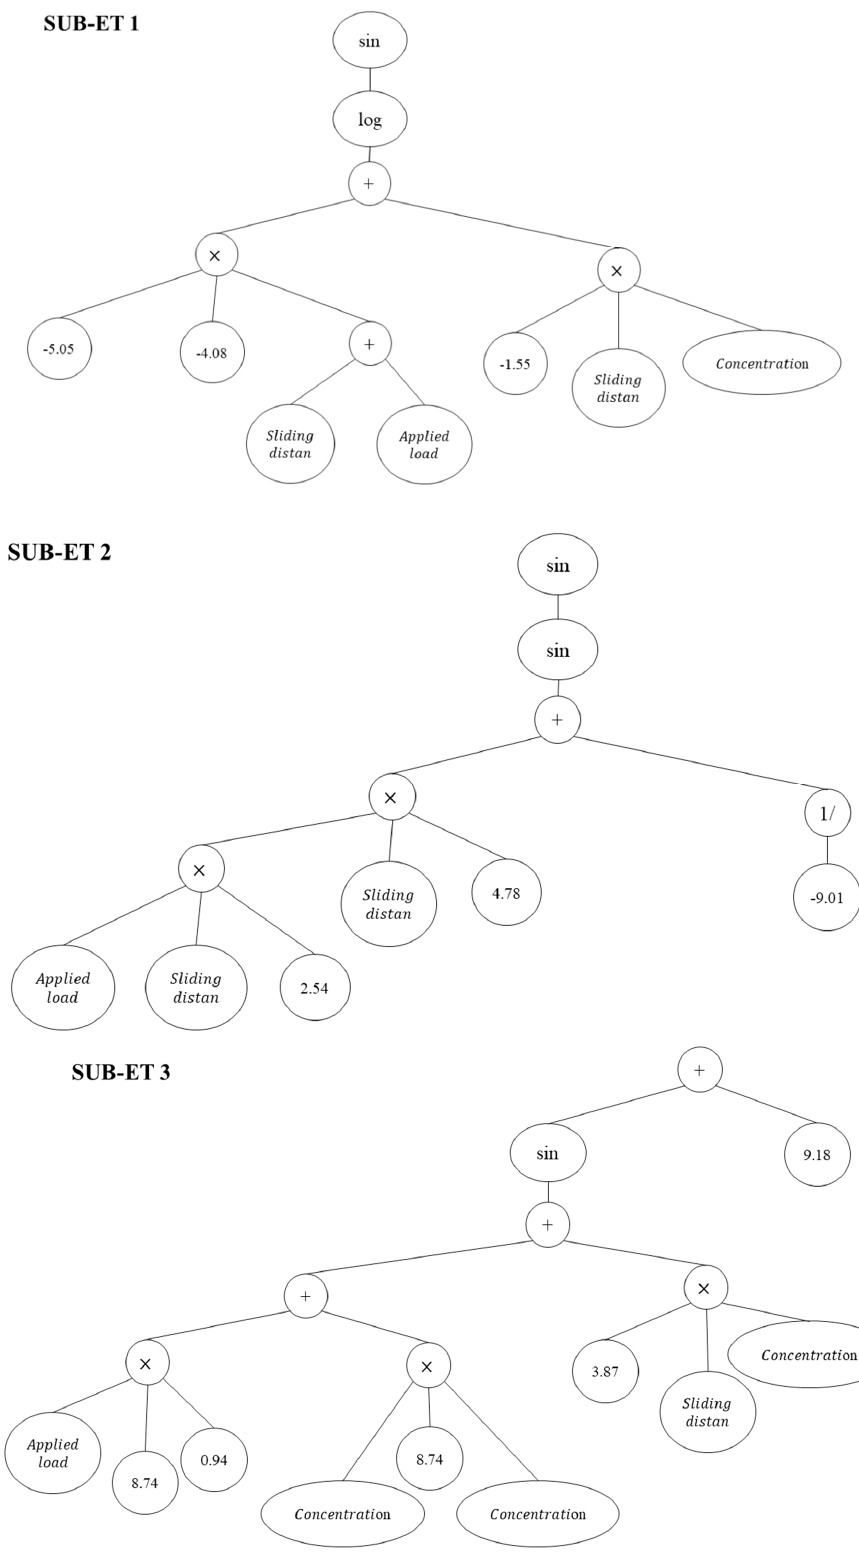
Figure 4. Expression tree (ET) of the GEP-3 (w4) model. By considering the SiC–ZrO 2 –Al hybrid composites, concentration of zirconia, sliding speed, sliding distance, and applied load as practical parameters of wear loss, a sensitivity analysis was employed for the determination of the most effective practical parameter on the microhardness of the nanocomposite coatings. Given that the best model for predict- ing microhardness is GEP-3 (w4), GEP-3 was employed for the sensitivity analysis (w4). In the GEP-3 (w4) models, the value for each practical parameter was set to zero while the values for the other parameters varied. By turning off the effect of the most affected pa- rameter on the GEP-3 (w4) model, namely the RMSE as the threshold, it is reasonable to have a larger deviation from the performance of the models [24]. The current density significantly affected the wear loss of the SiC–ZrO 2 –Al hybrid composites, as can be seen in Figure 5. The influence of each process parameter on the wear attributes of the constructed composites was then examined using the created model. To ascertain the impact of zirconia concentration on wear loss, the GEP-3 (w4) simulation was run with data altering the concentration of ZrO 2 from 5, 10, and 20% while maintaining the other process parameters such as sliding distance and applied stress, un- changed. Additionally, Figure 5 explores and illustrates the impact of other process fac- tors.